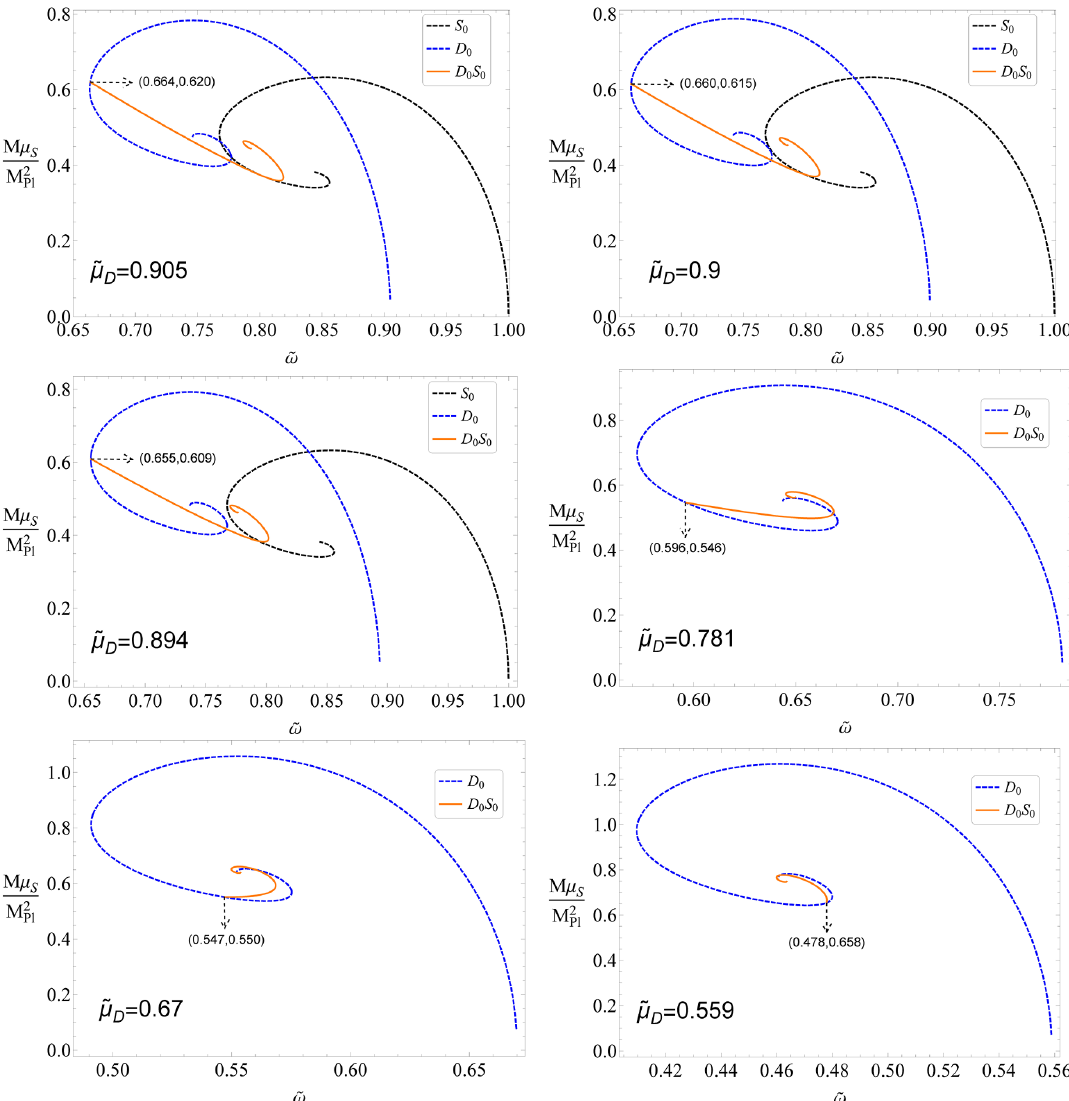
Figure 4. The ADM mass M of the DBSs as a function of the synchronized frequency ˜ ω for ˜ µ D = 0 . 905 , 0 . 9 , 0 . 894 , 0 . 781 , 0 . 67 , 0 . 559 . The black dashed line represents the S 0 state solutions with ˜ µ S = 1 , the blue dashed line represents the D 0 state solutions, and the orange line denote the coexisting state D 0 S 0 . All solutions have ˜ µ S = 1